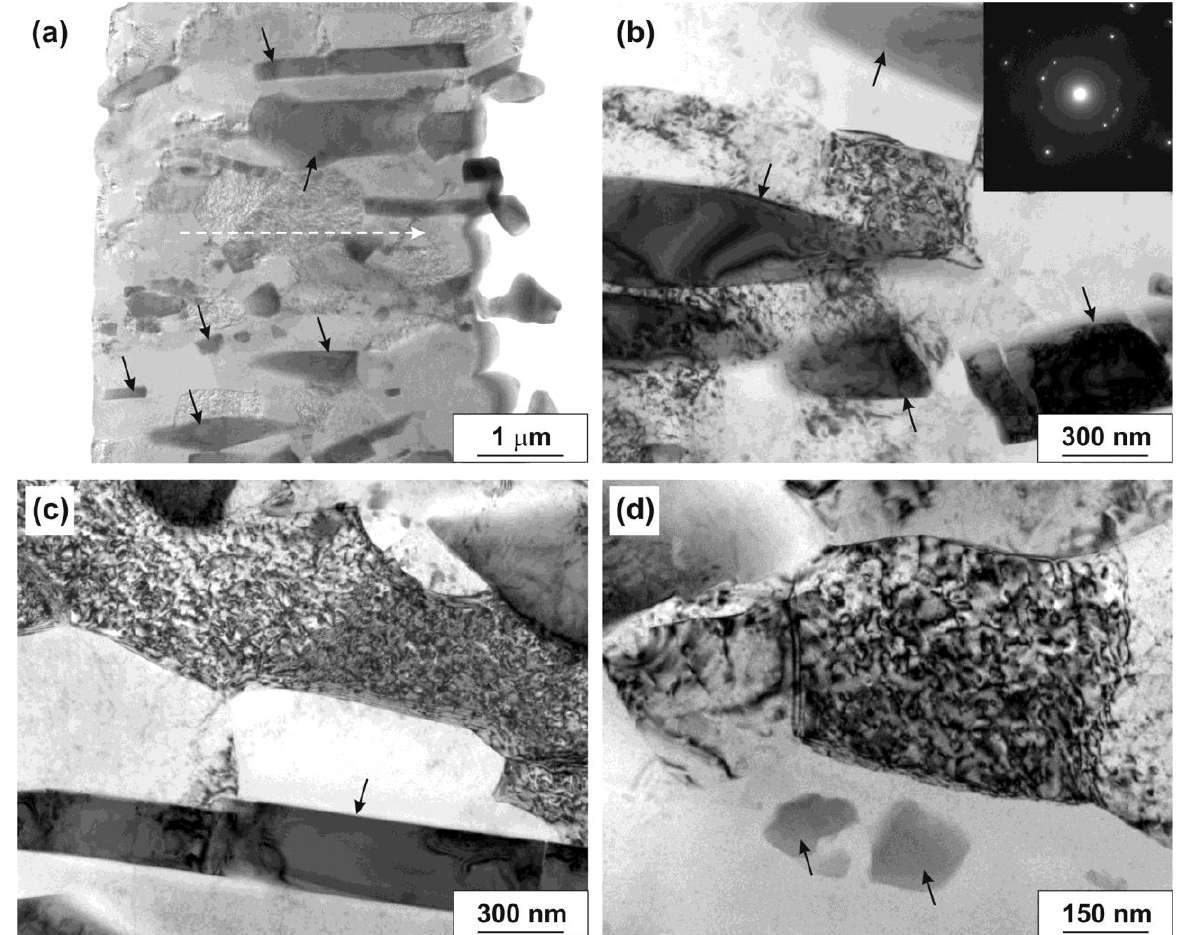
Figure 6. ( a ) General view of the lamella and ( b – d ) bright-field TEM images of the microstructure of the aluminum rod of the 2.5-mm diameter composite sample ( e = 4.16). The white dotted arrow indicates the direction of forging, and the black arrows indicate the Al 11 La 3 particles.